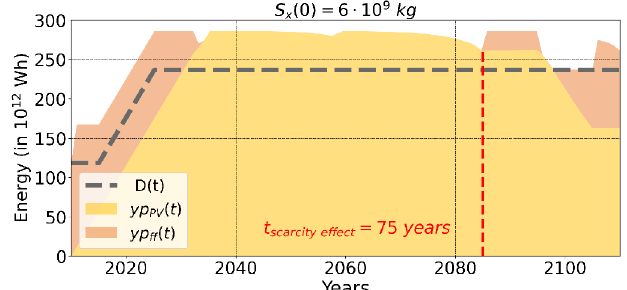
Fig. 7. Total fossil fuel consumption for runs with varying S x (0) with t f = 100 years and without recycling. Successful transitions (black dots) and failed transitions (gray dots). Red and pur- ple dashed lines respectively embody power generation carbon budget of France to maintain global warming below 1 . 5 and 2 ◦ C.